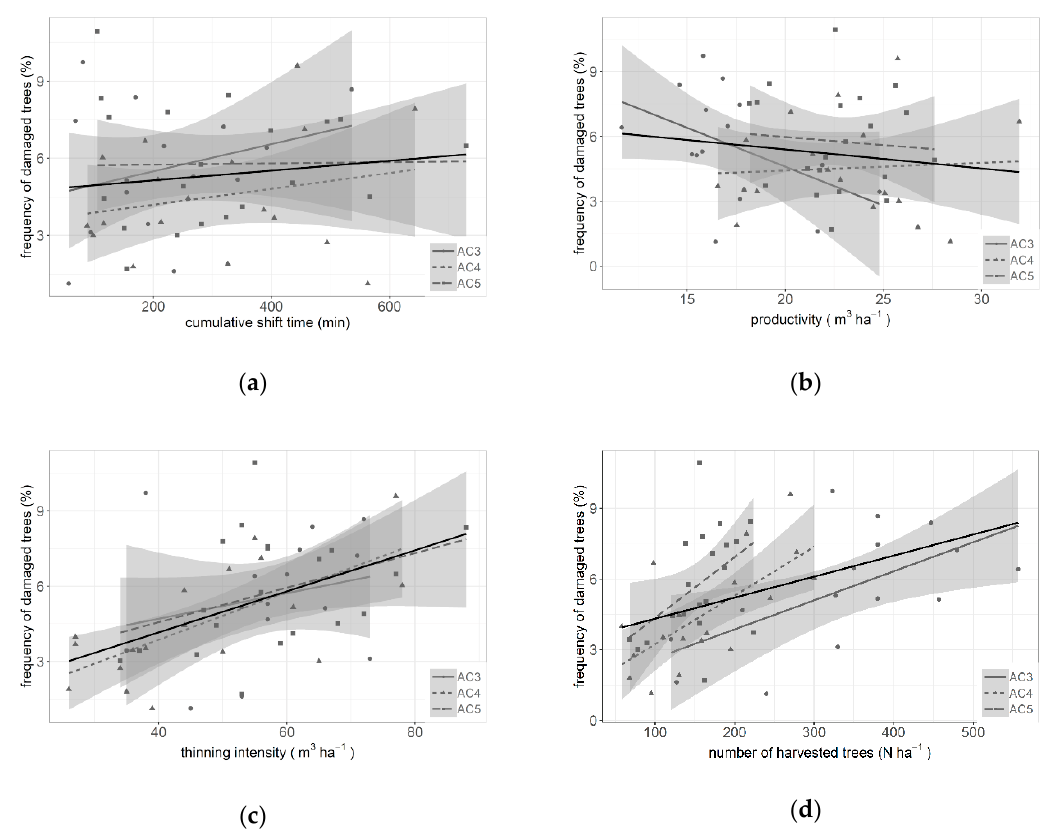
Figure 1. Frequency of damaged trees in age classes (AC) as a function of: ( a ) cumulative shift time; ( b ) productivity; ( c ) number of harvested trees; ( d ) number of extracted trees. Black curves represent mean values for all cases.